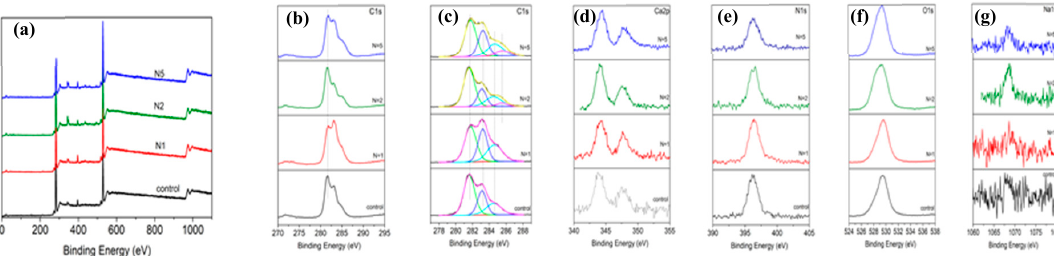
Figure 4. X-ray photoelectron spectroscopy ( XPS) spectra of pure chitosan thin films ( a ) non-treated and laser irradiated at I = 7.9 × 10 14 W/cm 2 for N = 1, 2, 5, 10; ( b )–( g ) resolved peaks of C 1s , C 1s- peak fitting, Ca 2p , N 1s , O 1s , Na 1s .